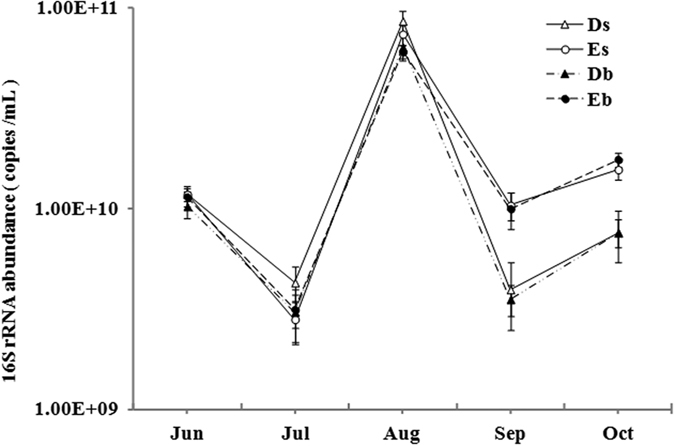
Abundance of bacterial 16S rRNA genes in the surface and bottom water (The capital letters D and E represent the ponds in which grass carp were fed with sudan grass and commercial feed, respectively.The lower case s and b represent the surface and bottom water layer, respectively). Error bars represent standard deviations.